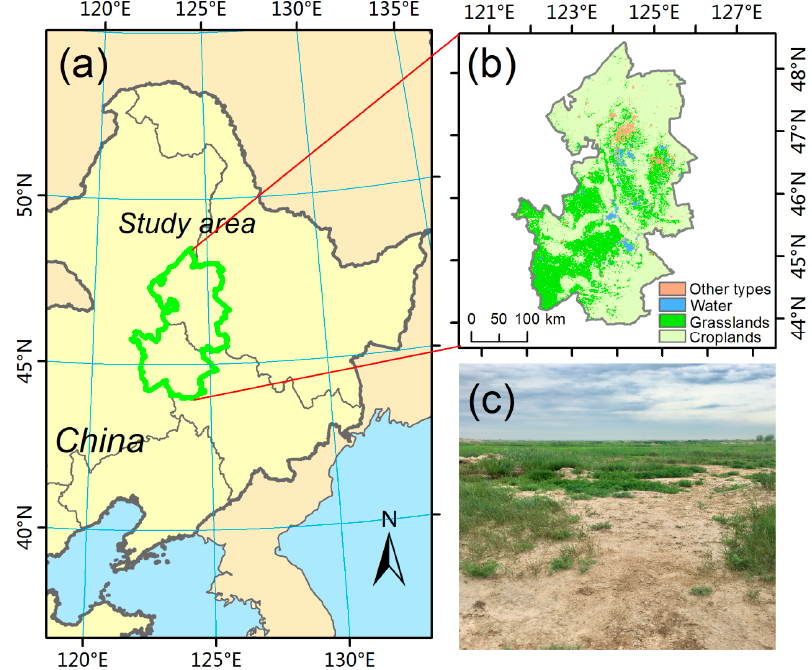
Figure 1. Geographical conditions of the study area. ( a ) Location of the Songnen grasslands; ( b ) land-cover types over the study area in 2013 from the MCD12Q1 product; ( c ) a photograph of the degraded grasslands in the study area.